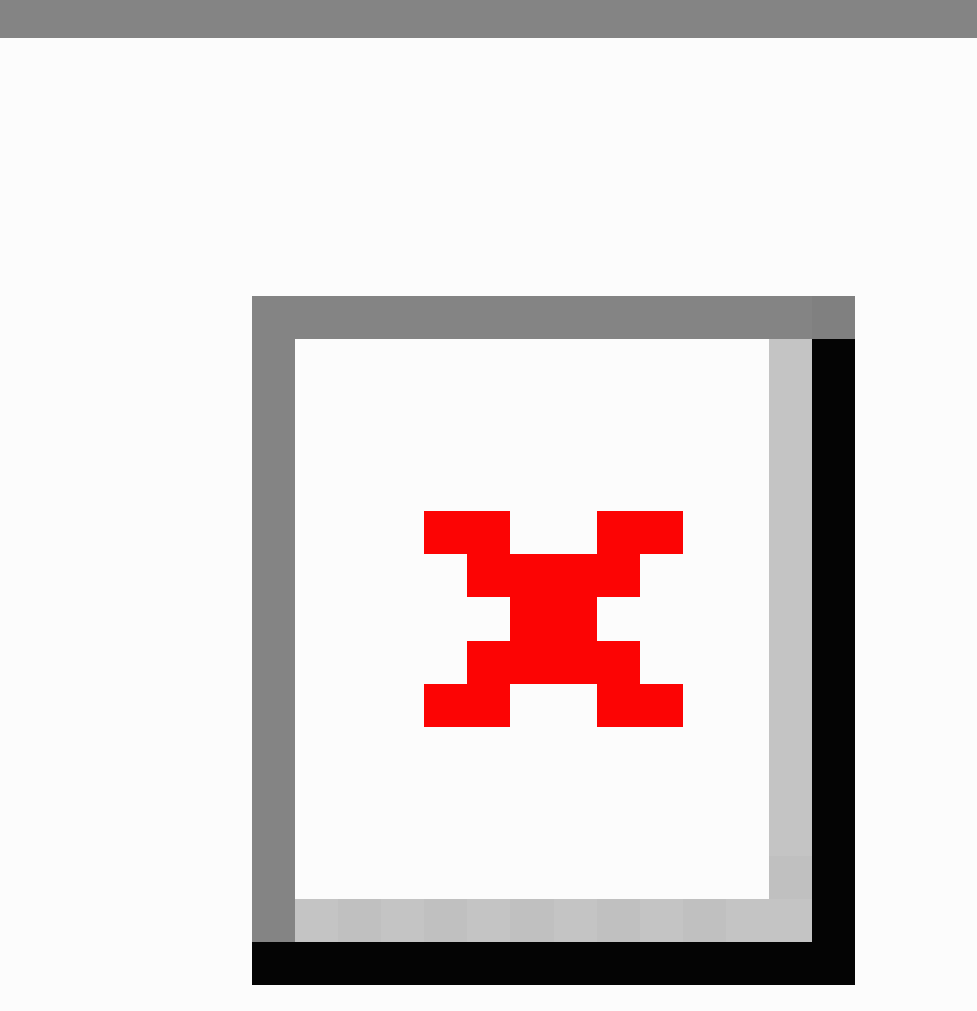
Figure 3. Mean (+ /- 95% CI) systolic and diastolic blood pressure change at 12 months in high and normal blood pressure groups (the systolic change in the high blood pressure group was significant, P <